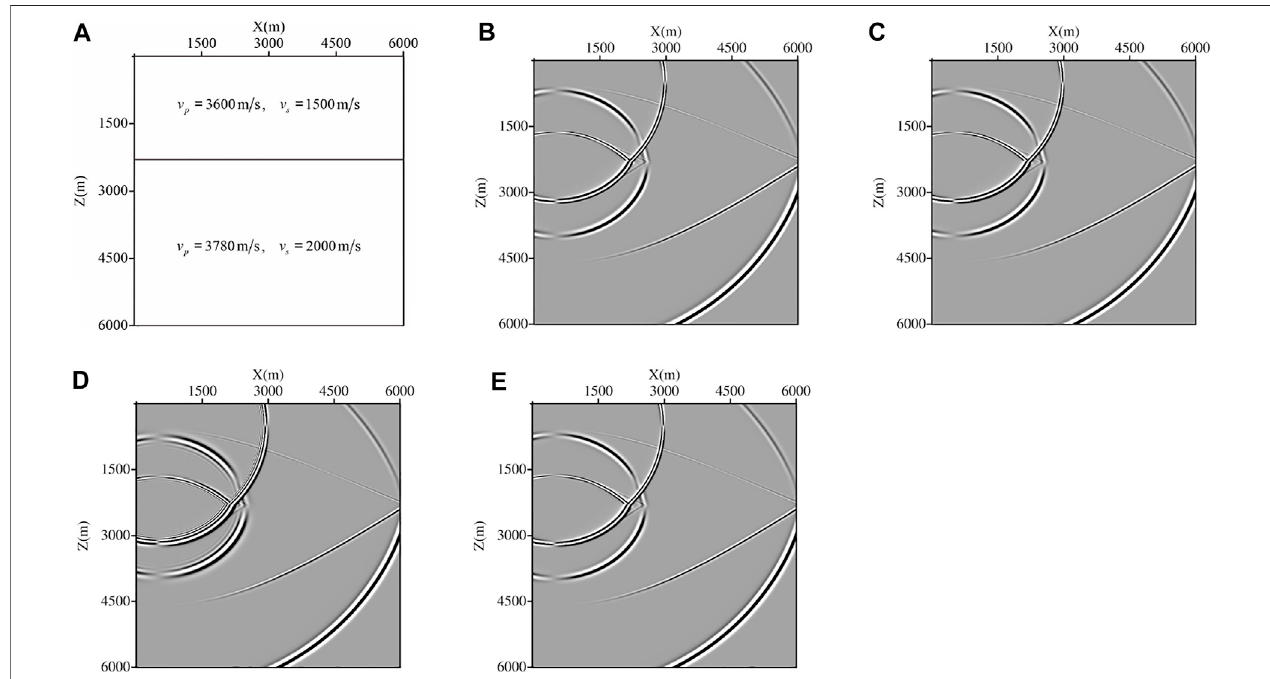
FIGURE 13 | Layered model and snapshots of the υ z component simulated by different SFD schemes. (A) Two-layered model. (B) C-SFD ( M =10) with Δ t (cid:2) 1ms. (C) M-SFD (M=8; N=1) with Δ t (cid:2) 1ms, the FD coef fi cients calculated based on the P-wave time-space domain dispersion relation. (D) M-SFD (M=8; N=1) with Δ t (cid:2) 1 . 5ms, the FD coef fi cients calculated based on the S-wave time-space domain dispersion relation. (E) M-SFD (M=8; N=1) with Δ t (cid:2) 1 . 5ms, solving the decomposed P-wave and S-wave